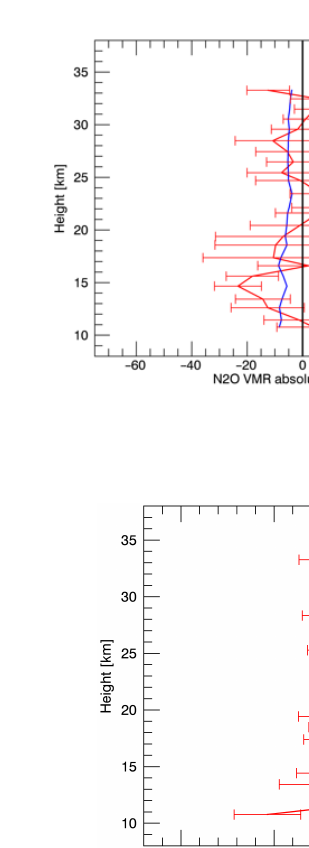
Figure 8. Same as Fig. 4, but instead of CH 4 now N 2 O.